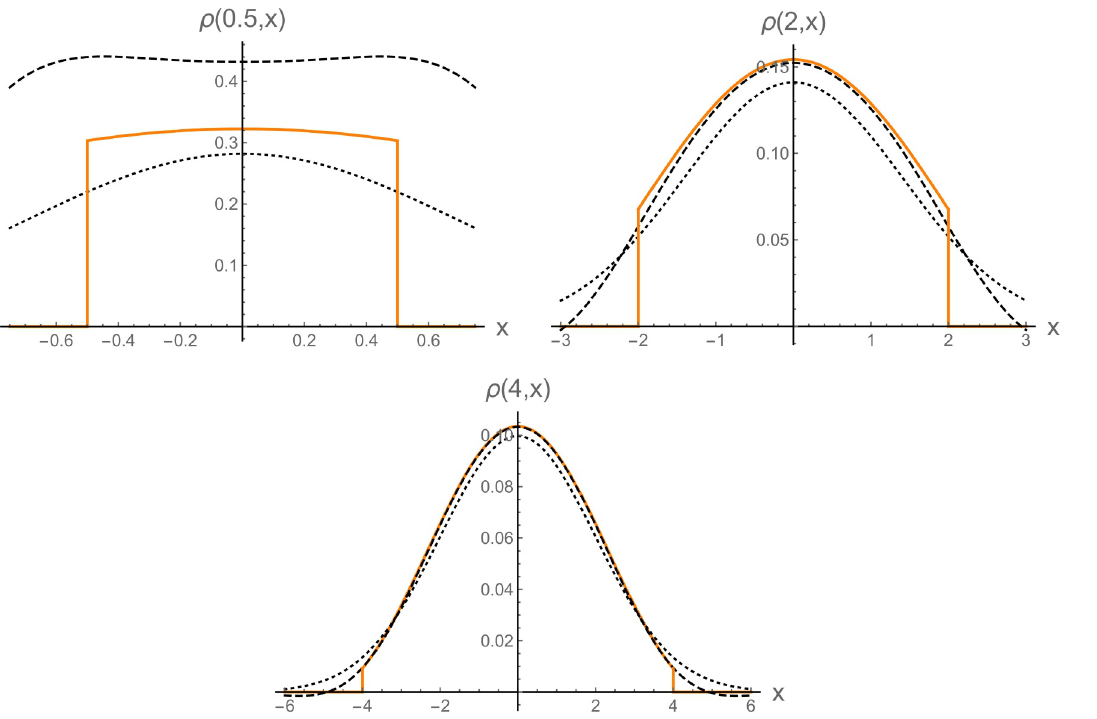
Figure 11 . Comparison between the exact ρ corresponding to δ -function initial data (solid orange) (cid:12) and the ρ ( H ) expansion truncated to first (dotted black) and third order (dashed (cid:12) (cid:15) (cid:15) =1